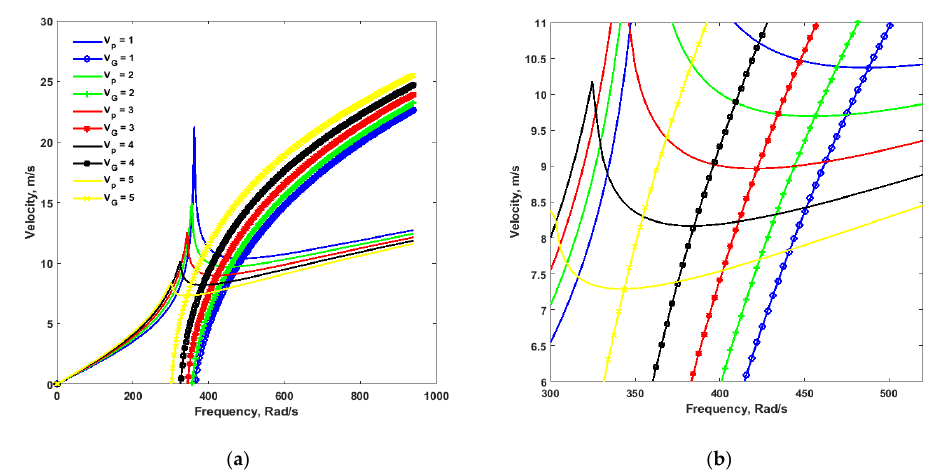
Figure 5. ( a ) Dispersion Curves for Level-4 at Varying Voltages. ( b ) Close View of Figure 5a.